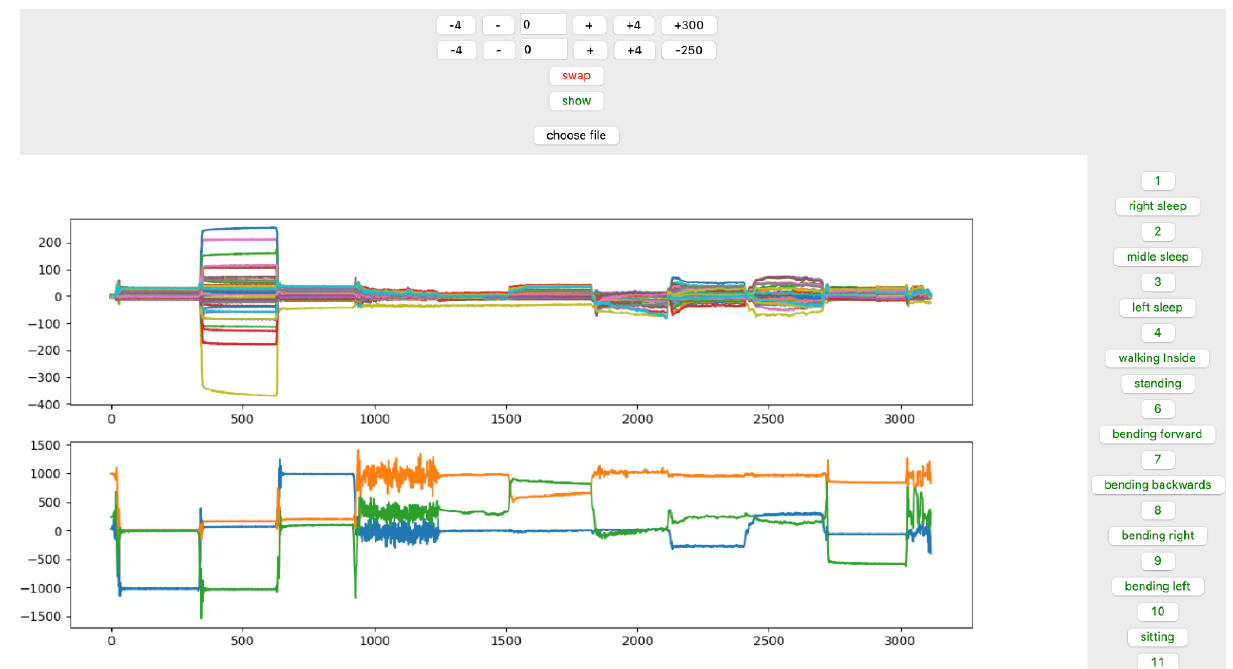
Figure 5. GUI for labeling indoor data. Time stamps and all three categories of activities are interactively configured and selected on the top and right side of the GUI, respectively; and in order to label the data, buttons on the right side of the panel can be used.